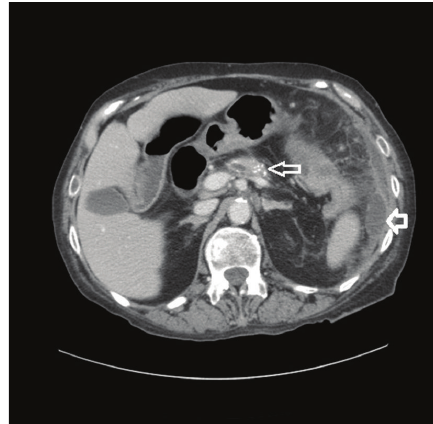
Figure 2: CT abdomen/pelvis done at outside hospital at time of admission: Fat arrow indicates fluid collection near the pancreatic tail and splenic flexure 3.5 cm. Skinny arrow calcification of the pancreas suggesting chronic pancreatitis.